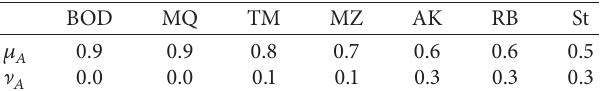
Table 2: Power of employees in terms of membership degree and nonmembership